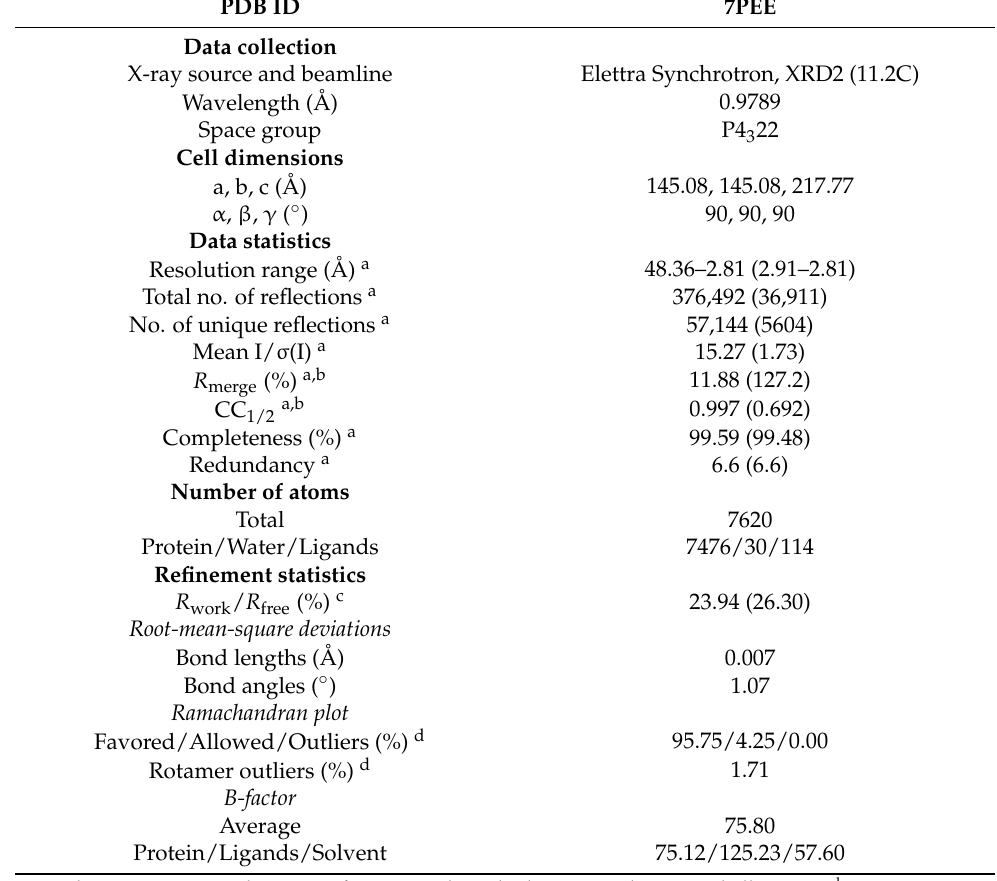
Table 1. Data collection and refinement statistics for the crystal structure of Trop2